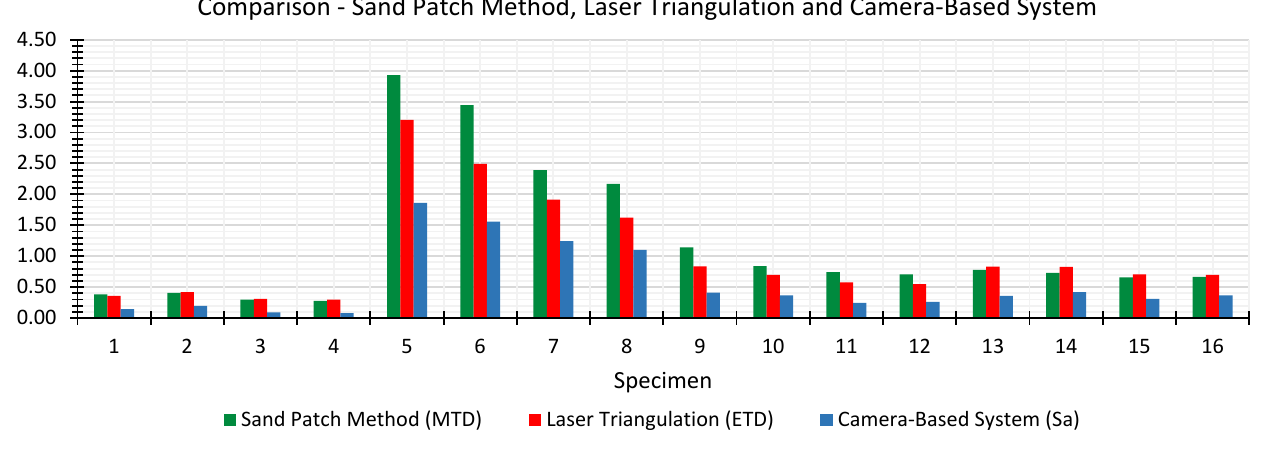
Figure 13. Bar chart of obtained roughness values for the 16 concrete specimens using the sand patch method, laser triangulation and our camera-based system.